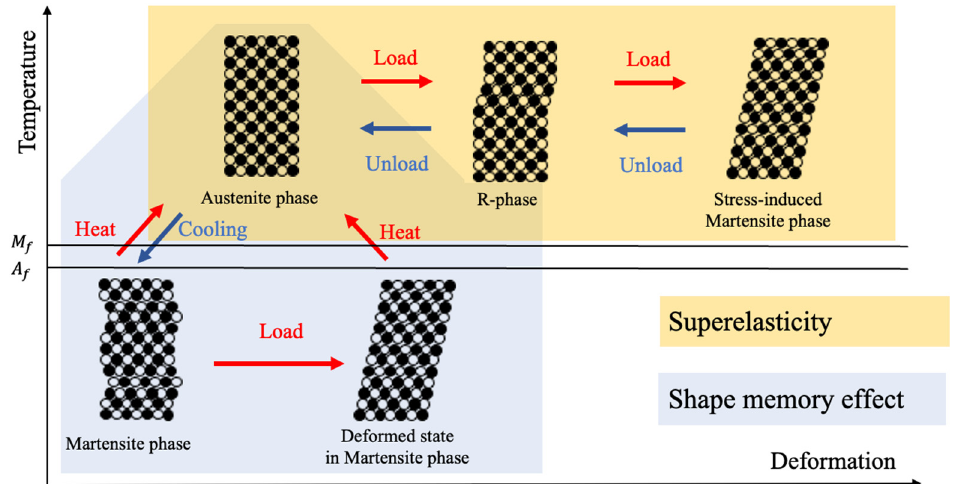
Figure 1. Physical properties of the deformation of an SMA.